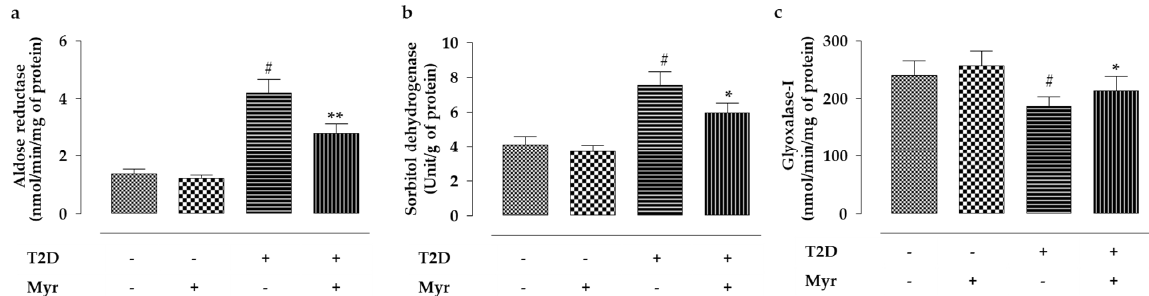
Figure 9. Effect of Myr on polyol enzymes, such as aldose reductase ( a ), sorbitol dehydrogenase ( b ), and glyoxalase-I ( c ) in the kidneys of T2D rats. Myr was able to decrease polyol activation in the kidneys of T2D rats. Data are expressed as mean ± SD ( n = 6). # Values significantly ( p < 0.01) differed from the normal control (T2D − ) group. * Values significantly ( p < 0.05) differed from the diabetic control (T2D+) group. ** Values significantly ( p < 0.01) differed from the diabetic control (T2D+) group.